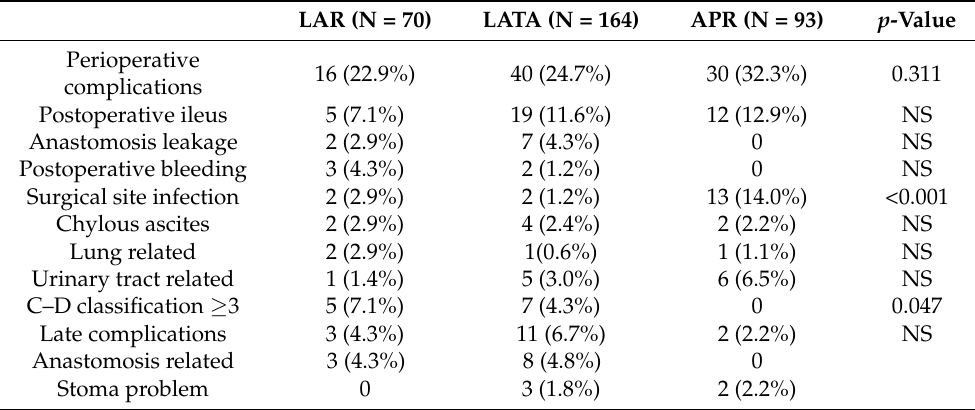
Table 3. Postoperative complication in